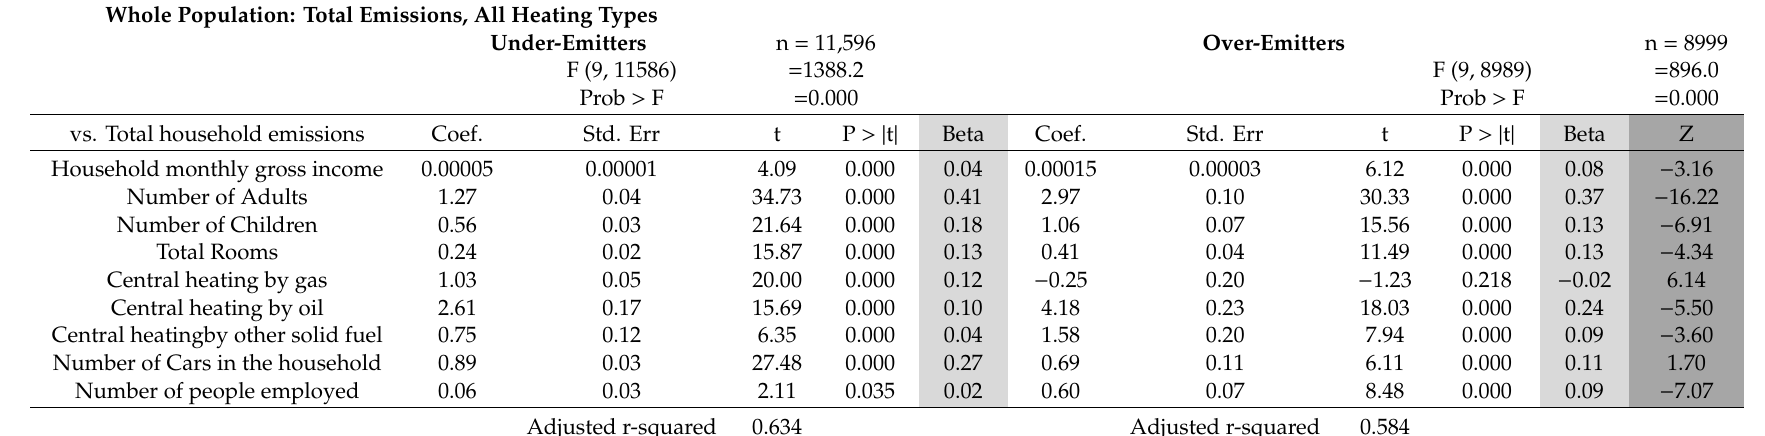
Table 4. Simple regression model of total household emissions by under- and over-emitters: whole population, all incomes. Whole Population: Total Emissions, All Heating